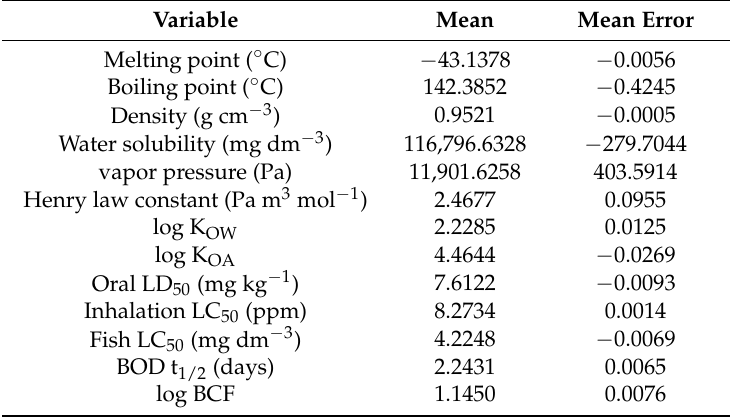
Table 4. Standard errors of predictions calculated with